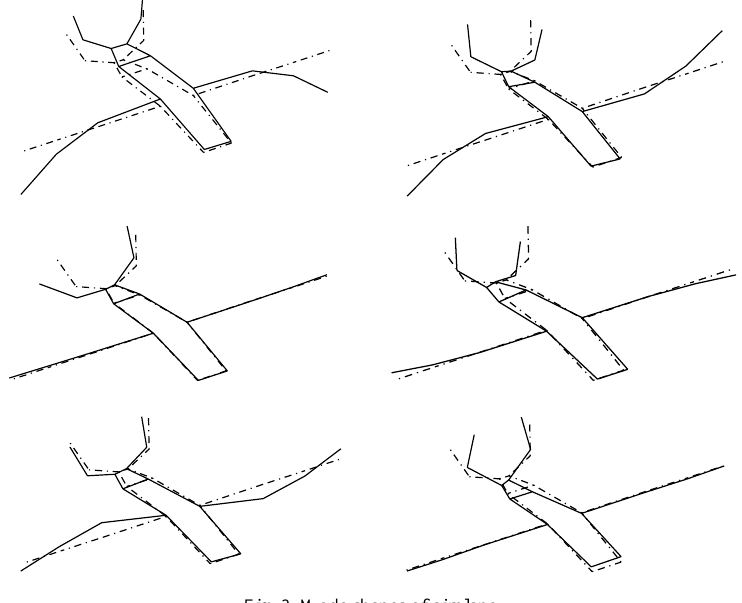
Fig. 3. Mode shapes of